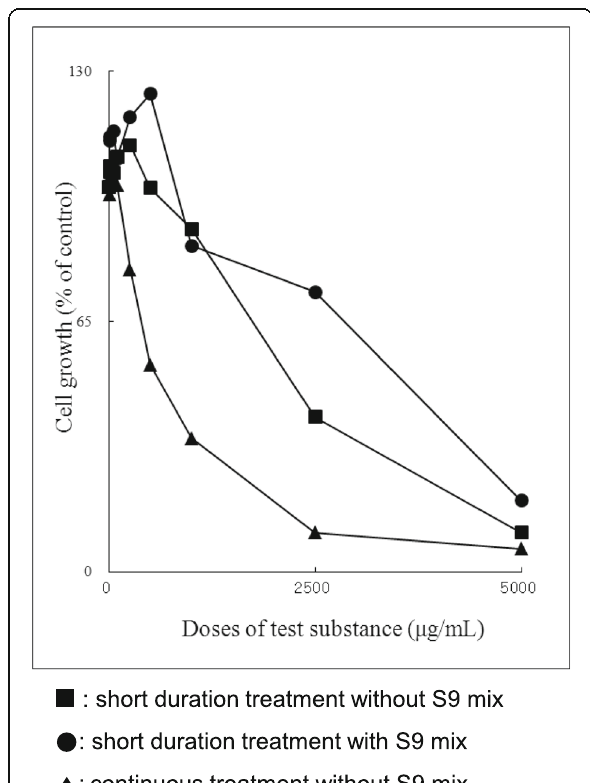
Fig. 1 Cell growth inhibition by SOCG. Chines hamster lung cells were exposed to various doses of SOCG for the short duration treatment (6 h) without and with S9 mix or continuous treatment (24 h) without S9 mix. SOCG shows a cell dose-dependent growth